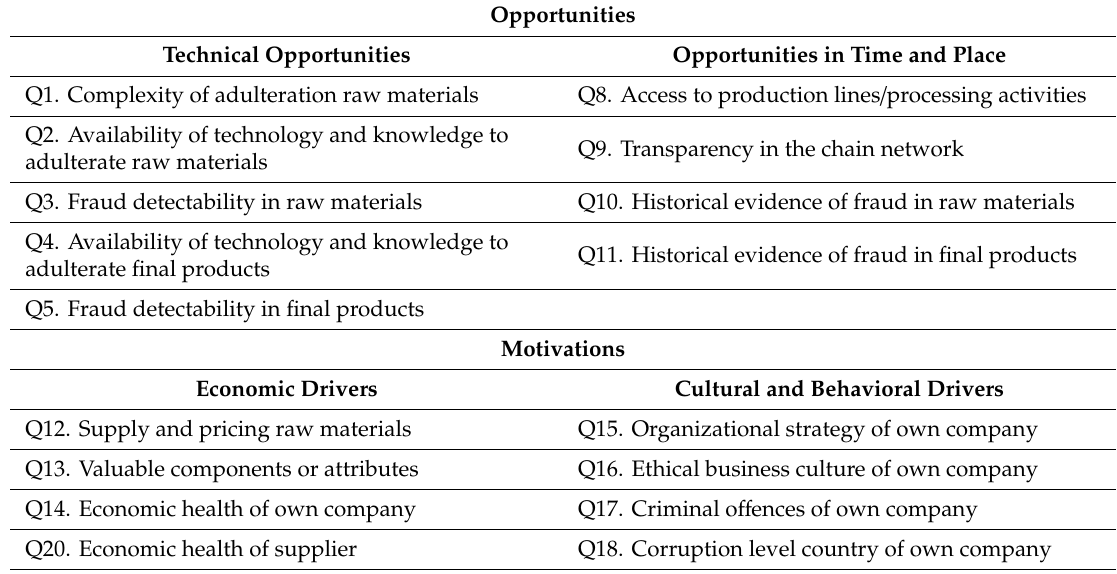
Table A1. Key elements, fraud factor categories and their associated fraud factors from the Food Fraud Vulnerability